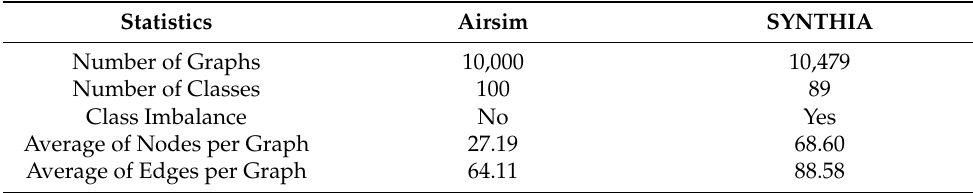
Table 1. Statistics of our graph